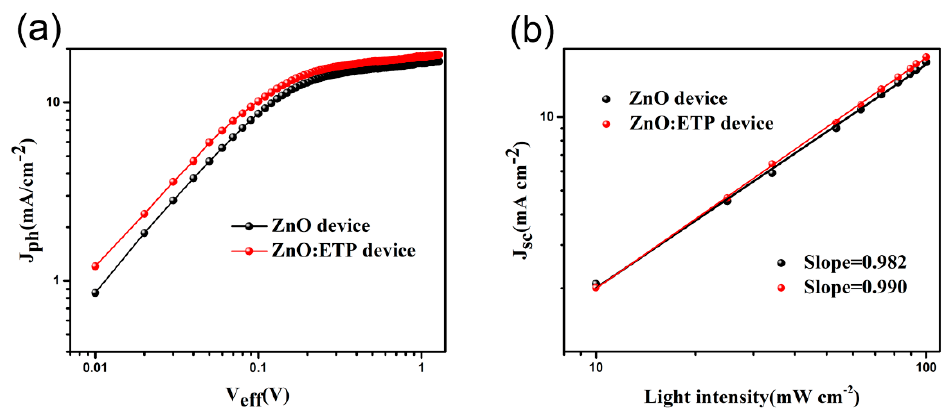
Figure 8. ( a ) Photocurrent density versus effective voltage curves under AM1.5 G illumination at 100 mW cm − 2 ; ( b ) light intensity dependence of J sc of the devices processed with ZnO and ZnO/ETP.